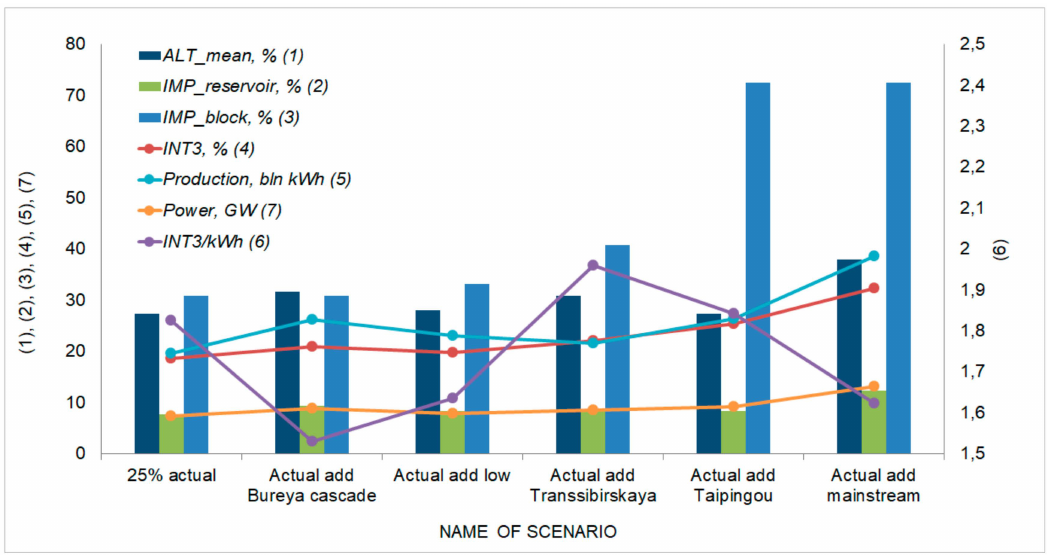
Figure 6. Potential scenarios of hydropower development based on the current